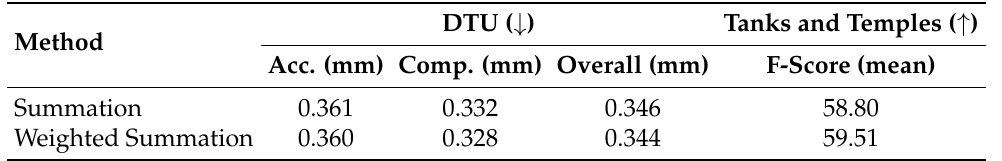
Table 6. Comparison of two ways to calculate the total error map.